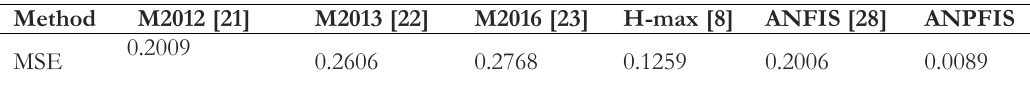
Table 2. The performance of the